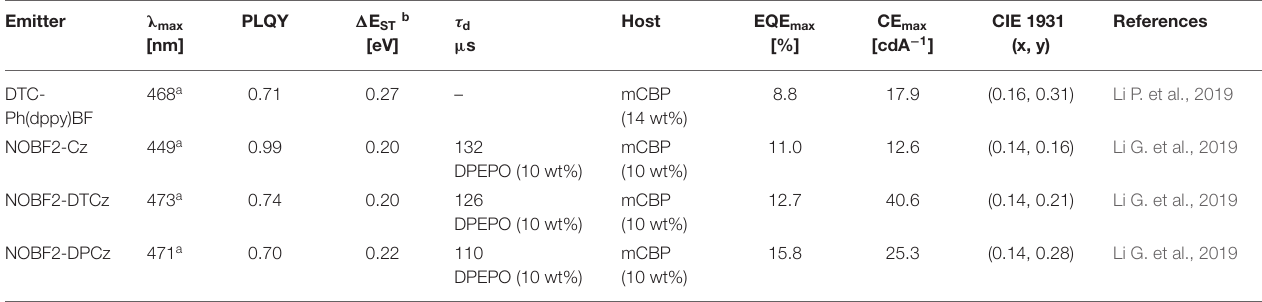
TABLE 3 | Summary of photophysical properties and device performance of the tetracoordinated difluoroboron-based blue thermally activated fluorescence (TADF) emitters.